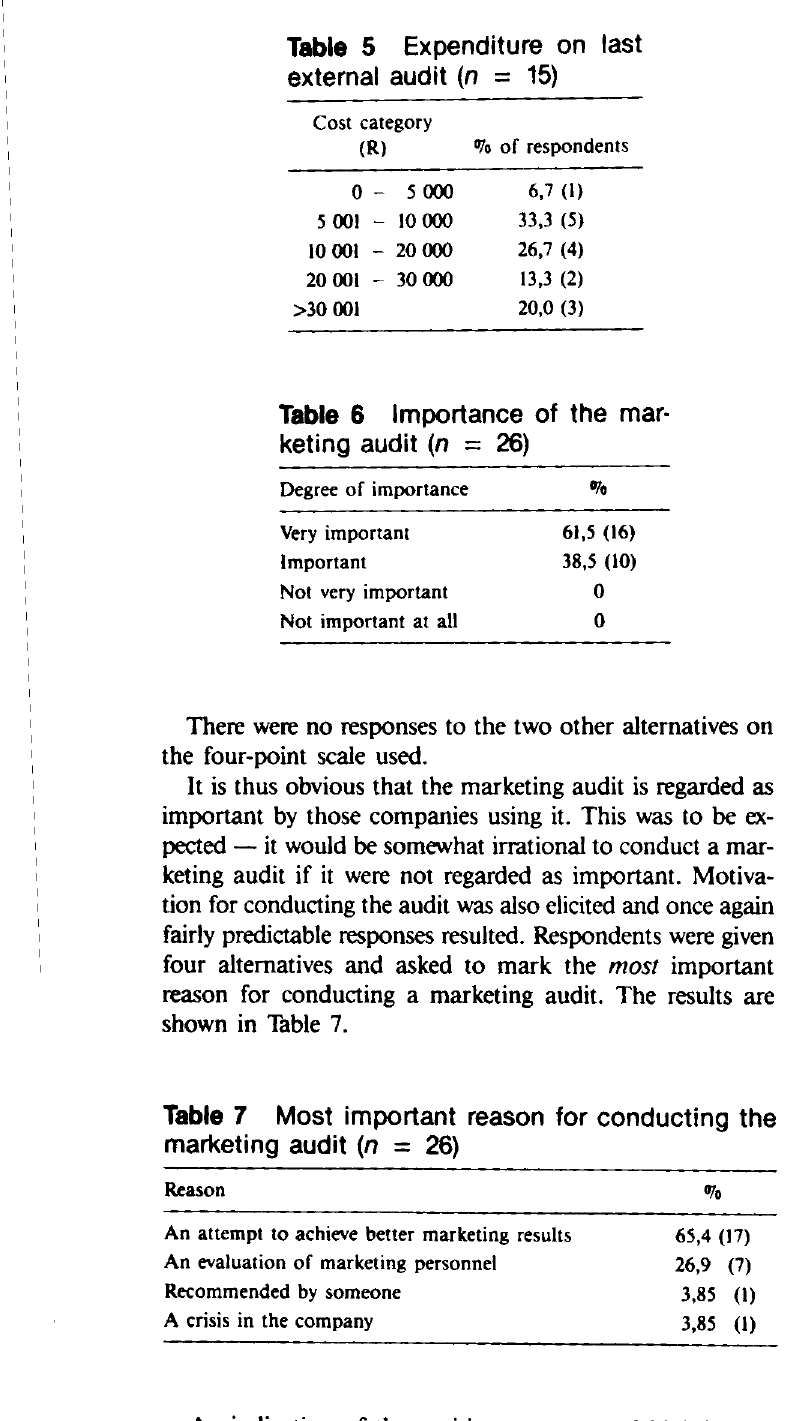
Expenditure on last